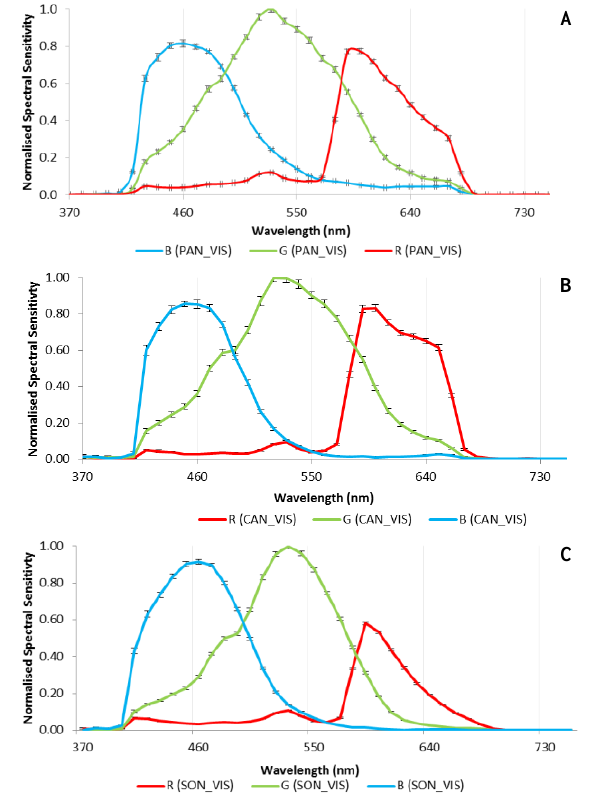
Figure 4: Spectral responses from the un-modified Panasonic (A), Canon (B) and Sony (C) cameras, normailised to the peak value of each cameras green channel.